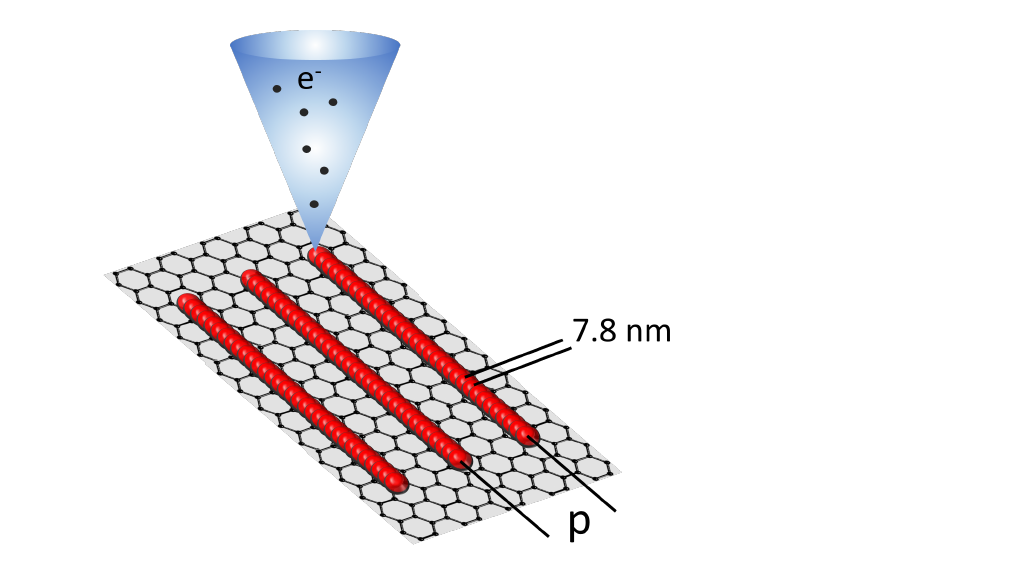
Figure 1. Sketch of the electron irradiation: red spots indicate the landing points of the primary e-beam. All lines are exposed with a step size of 7.8 nm (distance between the landing points) and are separated by a distance p